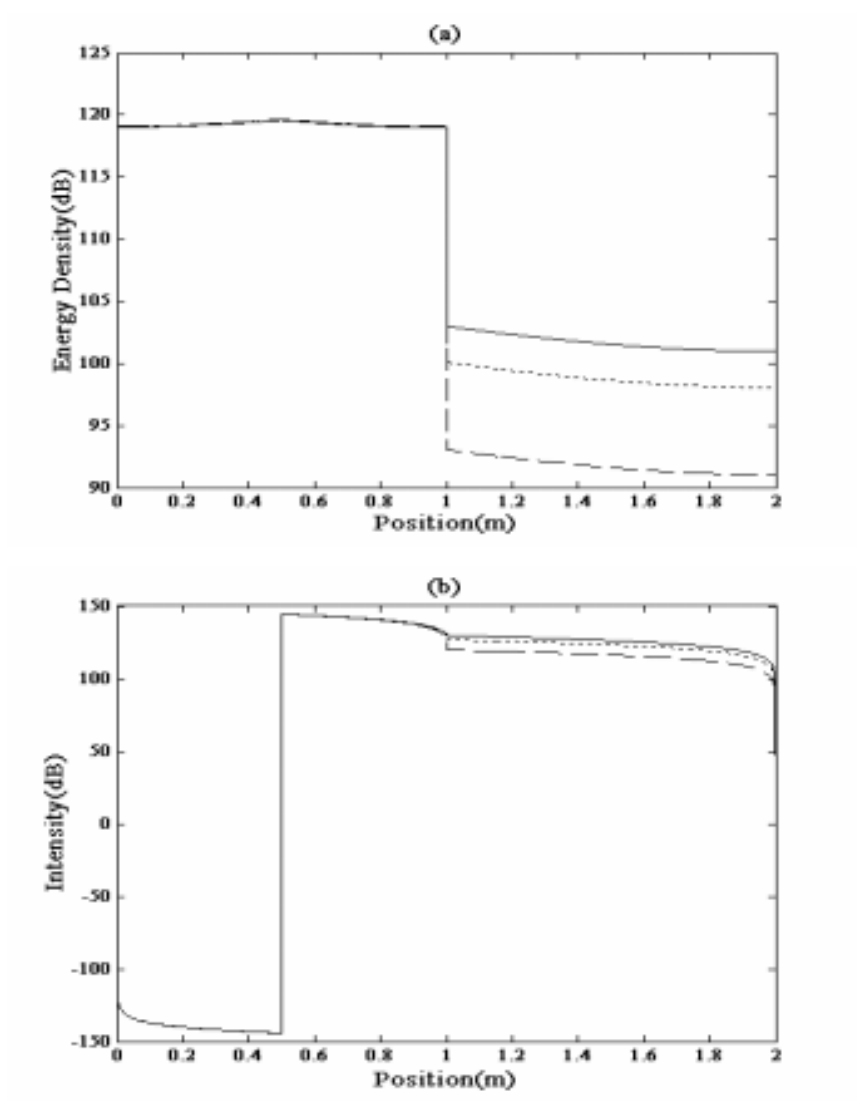
Fig. 7. Energy and intensity distributions of two-beam structure coupled when f = 1 kHz, K x = K y = 10 9 N/m, K θ = 10 6 Nm/rad, C x = C y = 10 7 Ns/m, C θ = 10 4 Nms/rad and η = 0.1. (a) flexural wave energy, (b) flexural wave